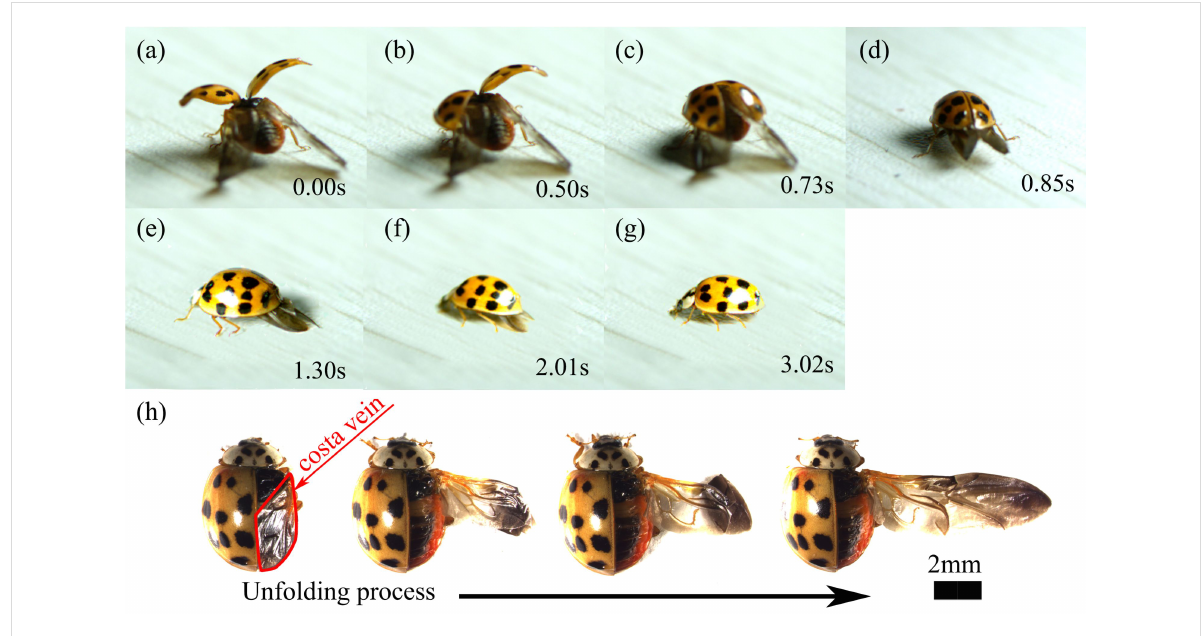
Figure 6: The hindwing folding and unfolding processes of H. axyridis . (a–g) Dynamic views of folding acquired with a high-speed camera and (h) static views of unfolding actions acquired with a stereomicroscope.